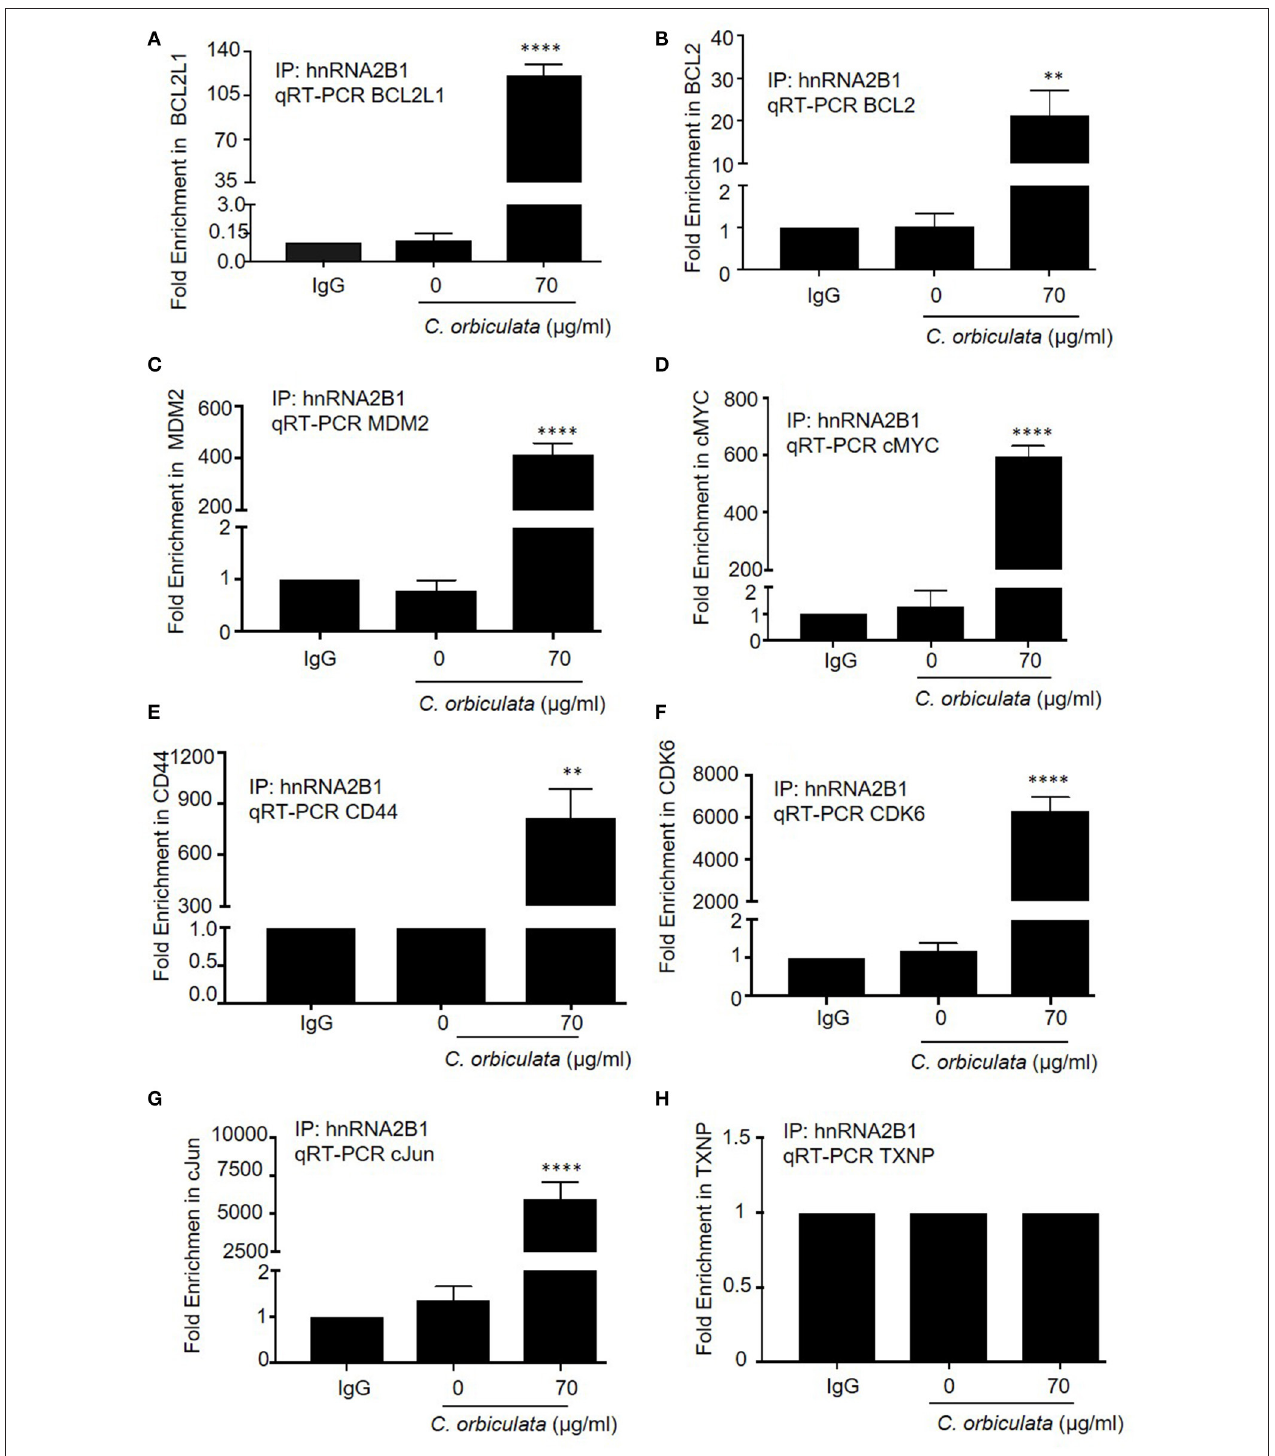
FIGURE 7 | RNA-Binding Protein Immunoprecipitation RIP to detect interaction of hnRNPA2B1 with (A) BCL2L1, (B) BCL2, (C) MDM2, (D) cMYC, (E) CD44, (F) CDK6, (G) cJun, and (H) TXNP. Lysates prepared from HCT116 colon cancer cells treated with 70 µ g/ml C. orbiculata were subjected to immunoprecipitation using 5 µ g of either a normal mouse IgG or Anti-hnRNPA2B1 antibody. Successful immunoprecipitation of hnRNPA2B1-associated RNA was verified by qPCR using primers specific for the 8 mRNAs. Results are presented as fold increase relative to IgG. There is a clear significant increase in the binding of 7 (A–G) of the 8 mRNAs to hnRNPA2B1 in cells treated with the crude plant extract ( n = 3, mean ± SEM). For statistical analysis, One-way ANOVA with Dunnett’s multiple comparison test was used, * P < 0.1, ** P < 0.01, *** P < 0.001, **** P < 0.0001.